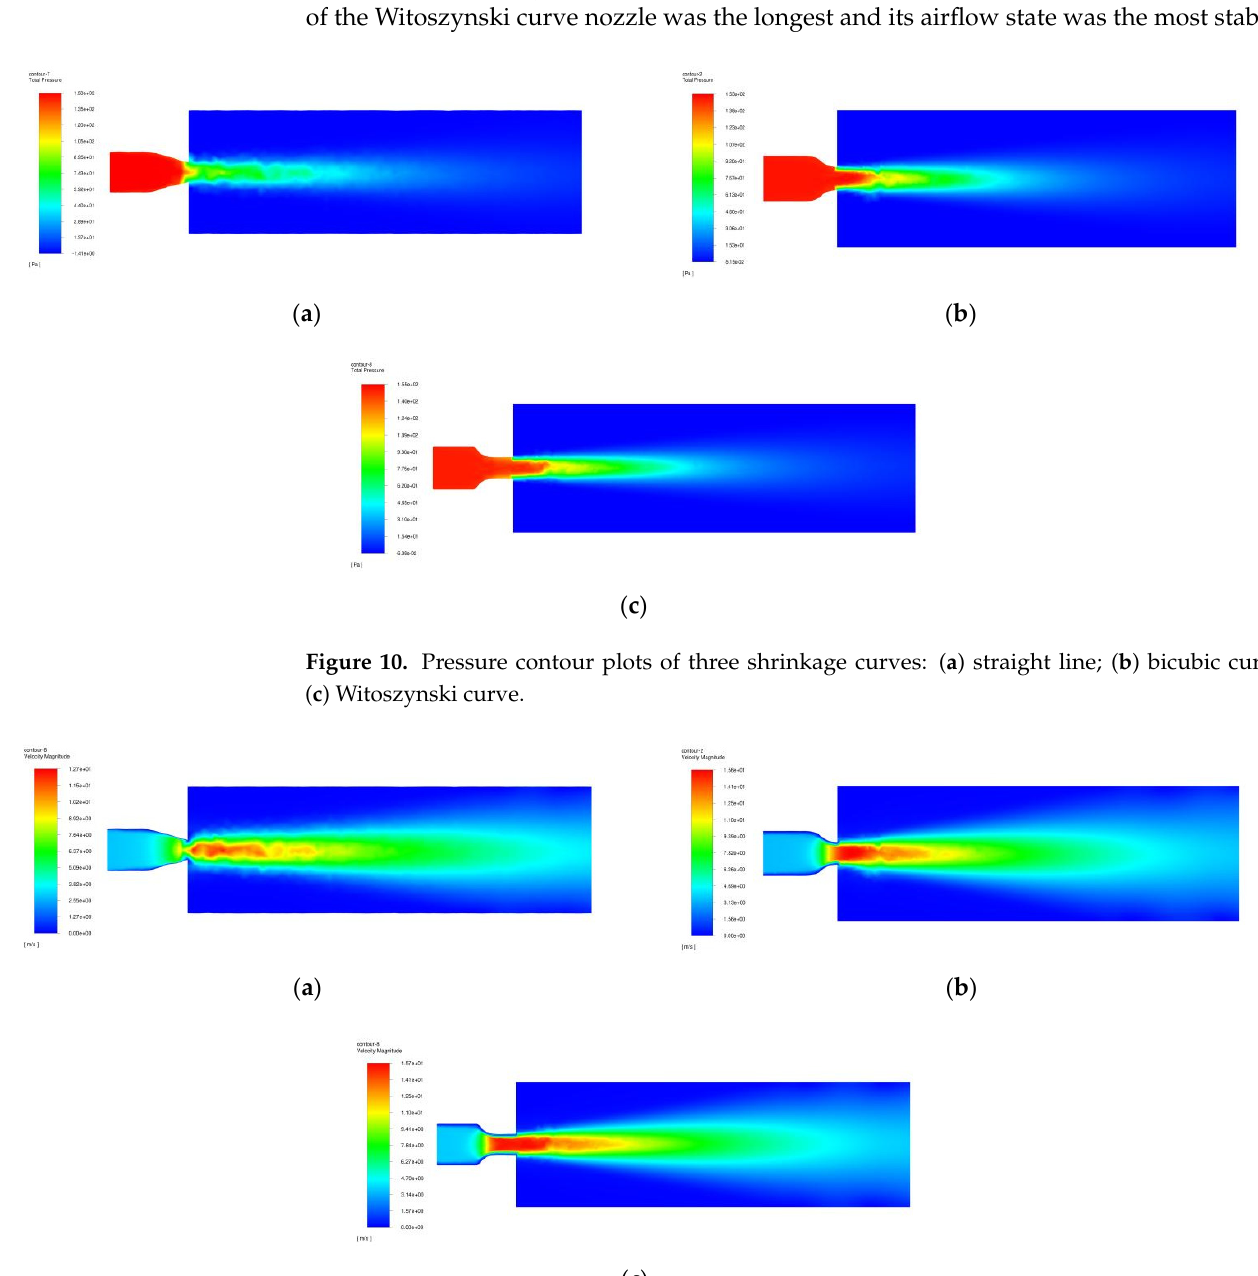
( b ) Figure 9. Simulation models and meshing: ( a ) simulation model; ( b ) simulation meshing. 3.3. Simulation Results and Analysis After the airflow passes through the nozzle structure, it is in a free outflow state and its pressure value will continue to decrease with its distance from the outflow. Figure 10